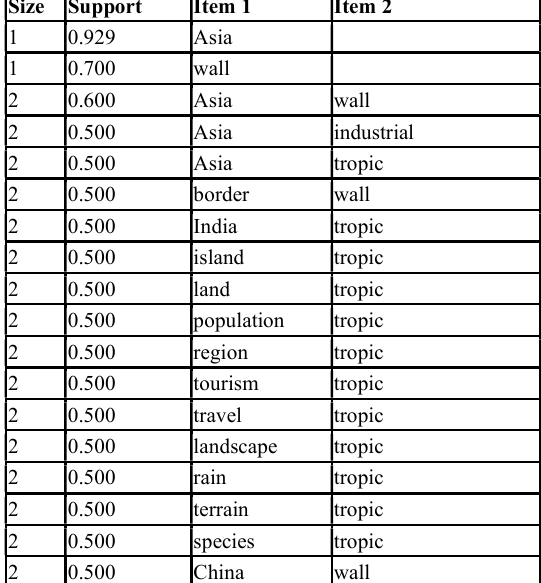
Table 1. Most Indicative Association